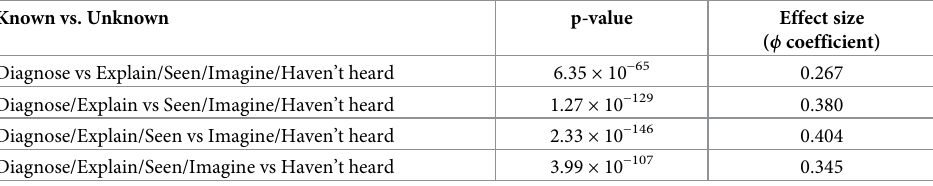
Table 6. Answer thresholds and their statistical